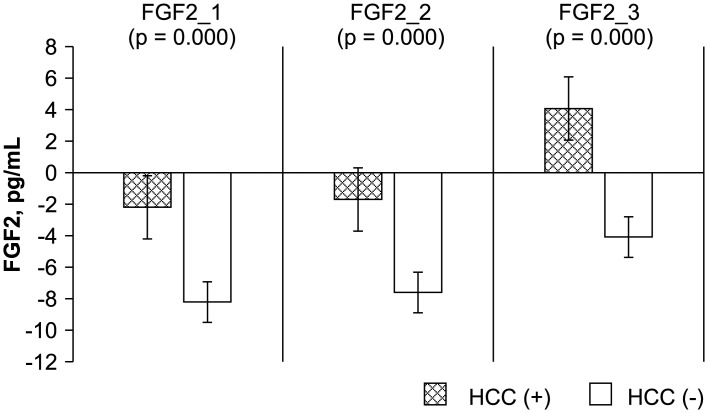
Statistical analysis of FGF-2, survivin, Ki67, endostatin, and VEGF levels, as measured by ELISA before (_1), early after (_2), and late after (_3) after living donor liver transplantation (LDLT).The Mann-Whitney U test was used to compare the differences in the biomarkers at the various time points between the recipients with and those without HCC recurrence.